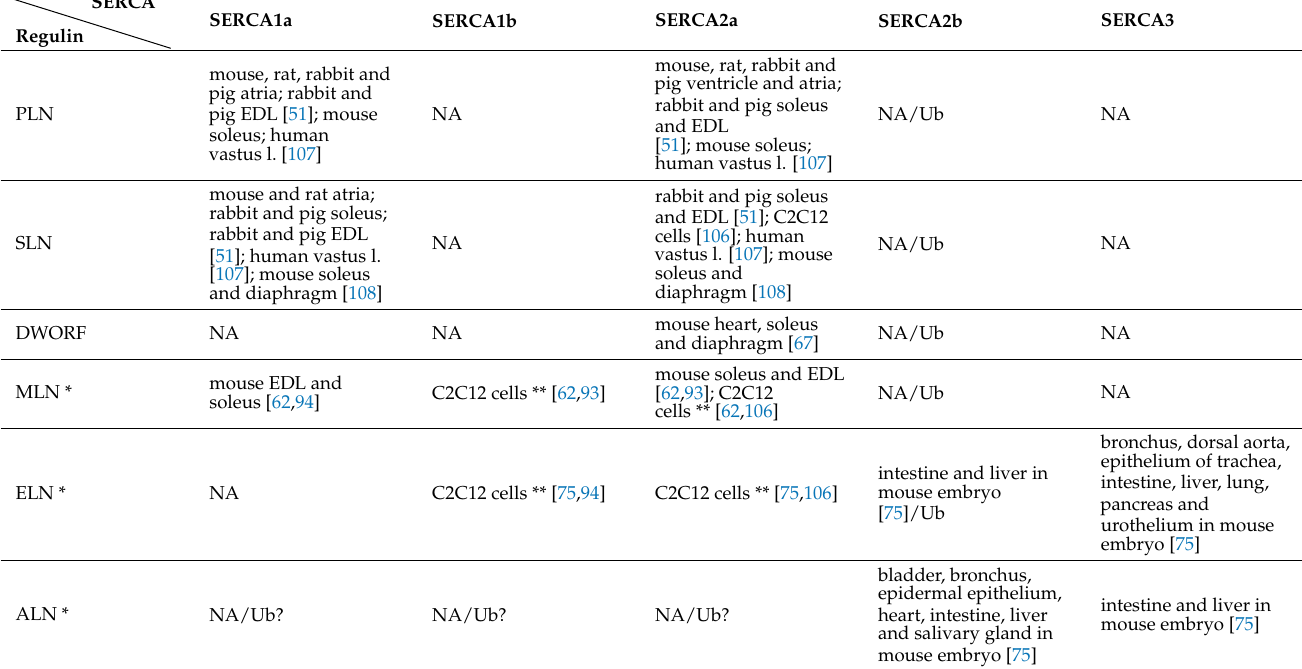
Table 1. Co-expression of regulins and SERCA proteins in cells and tissues of various species. It is noticeable that many possible combinations have not been analysed yet and some regulins have not been detected with specific antibody. vastus l.–vastus lateralis, NA–not available, Ub–based on its expression so far SERCA2b has been in every cell, Ub?–the similar pattern can be expected for ALN as for SERCA2b [75]. * It has been detected by in situ hybridization at best, except in C2C12 cells where the MLN peptide expression was monitored by a FLAG epitope tag introduced to the endogenous MLN locus [62]. ** Note that SERCA reported at the protein level in C2C12 cells is mainly SERCA1b [93] and SERCA2a [106]. Note also that RT–PCR analysis of various muscles and organs for regulin and SERCA mRNAs with in situ images has been further detailed in